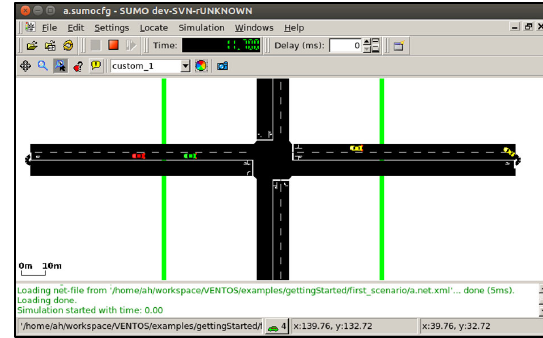
Fig. 2. Scenario 1: Message is Accepted, and Vehicle Change its Lane to Avoid the Accident